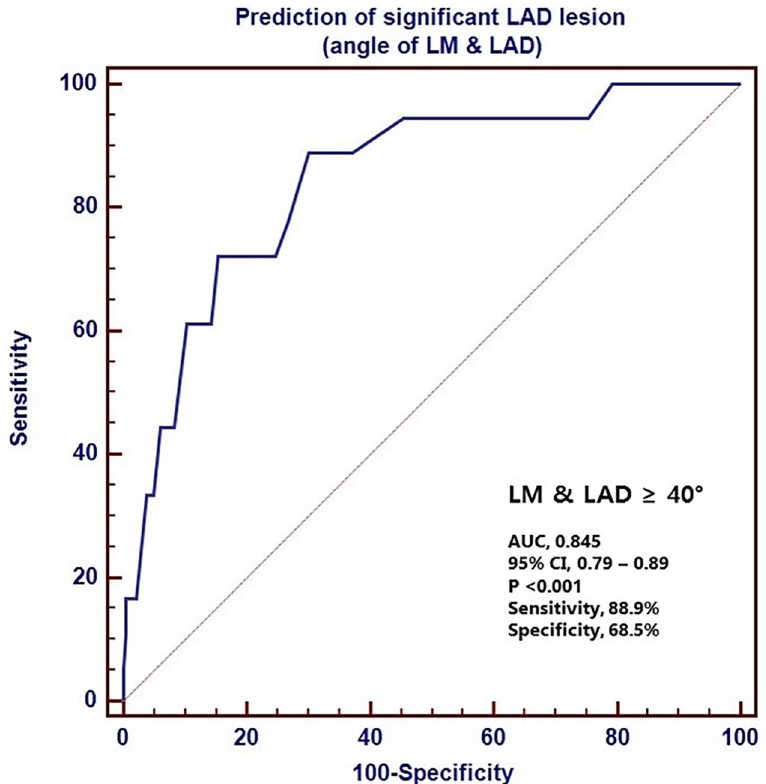
Figure 5. The receiver operating characteristic (ROC) curve for the LM-LAD angle in the prediction of LAD stenosis. The area under the curve is 0.845. LM—left main coronary artery, LAD—left anterior descending, CI—confidence interval. Reprinted with permission under the open access from Moon et al. [15] 2018, Public Library of Science.